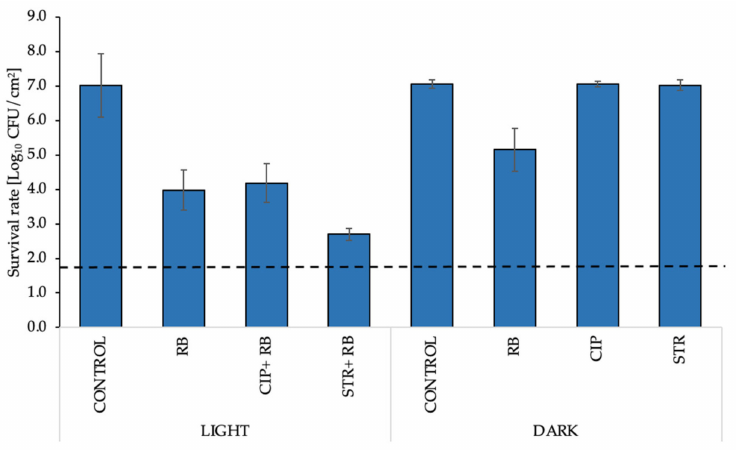
Figure 4. Assessment of the survival rate of E. faecalis biofilms grown on coupons and treated under various conditions: control (nontreated); RB (5 µ M); CIP (5 × MIC); STR (3 × MIC) in dark or treated with green light (7.95 J/cm 2 ). For each condition, three coupons were analyzed. The detection limit was 39.5 CFU/cm 2